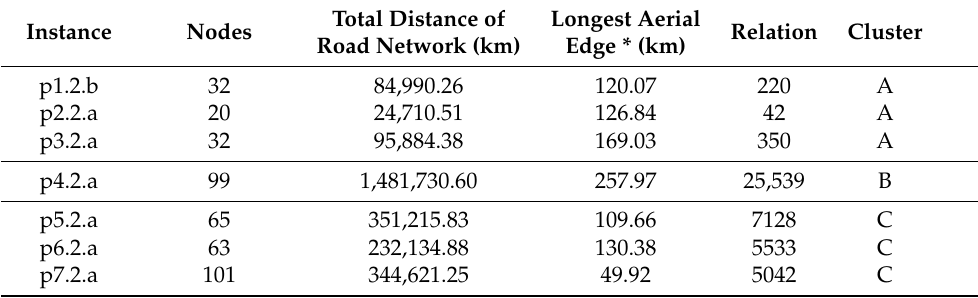
Table 2. Characteristics of instances and cluster type. Instance Nodes